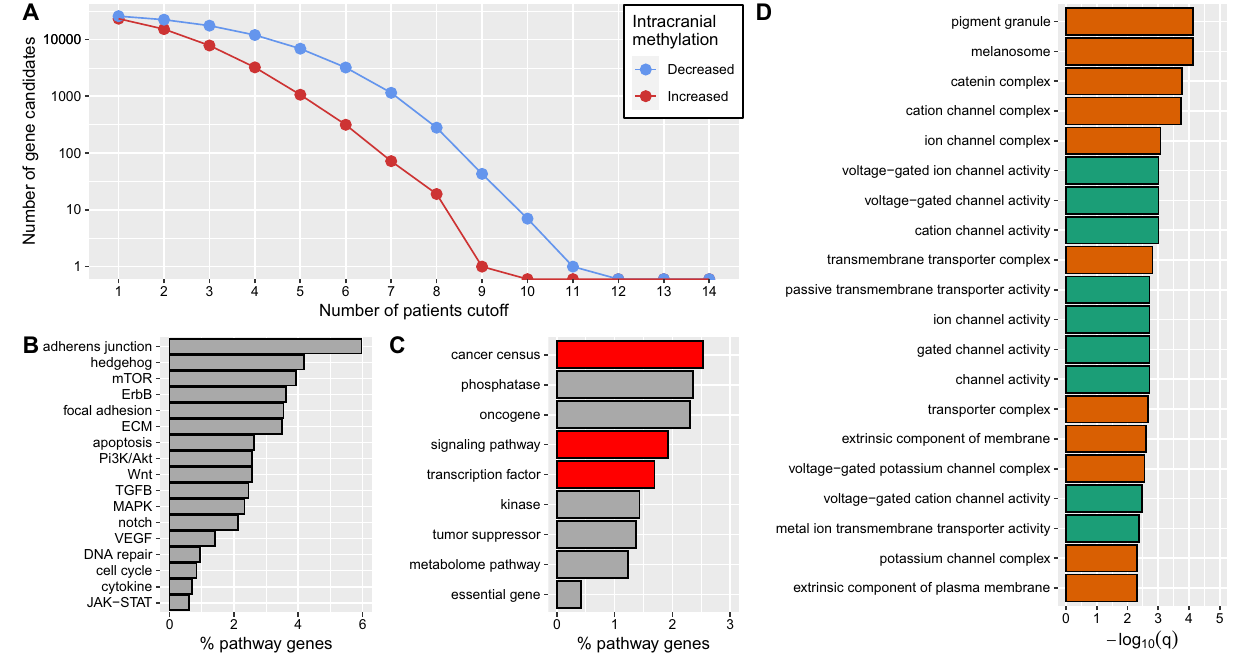
Figure 5. General overview of gene candidates with altered methylation between intra- and extracranial metastases pairs. ( A ) Number of gene candidates with decreased (blue) and increased (red) methylation in intracranial metastases that were identified in at least a specific number of patients (x-axis) in relation to their corresponding extracranial metastases. ( B – D ) Analysis of gene annotations of candidate genes that were altered in the same direction in at least 8 patients. ( B ) Percentages of affected genes of specific signaling pathways among the gene candidates that showed differential methylation. ( C ) Percentages of candidate genes in general functional annotation categories. Significantly overrepresented categories are shown in red (FDR-adjusted p value < 0.05). ( D ) Top overrepresented gene ontology terms at the significance cutoff of − log 10 (q-value) > 2 representing molecular function (green) and cellular composition